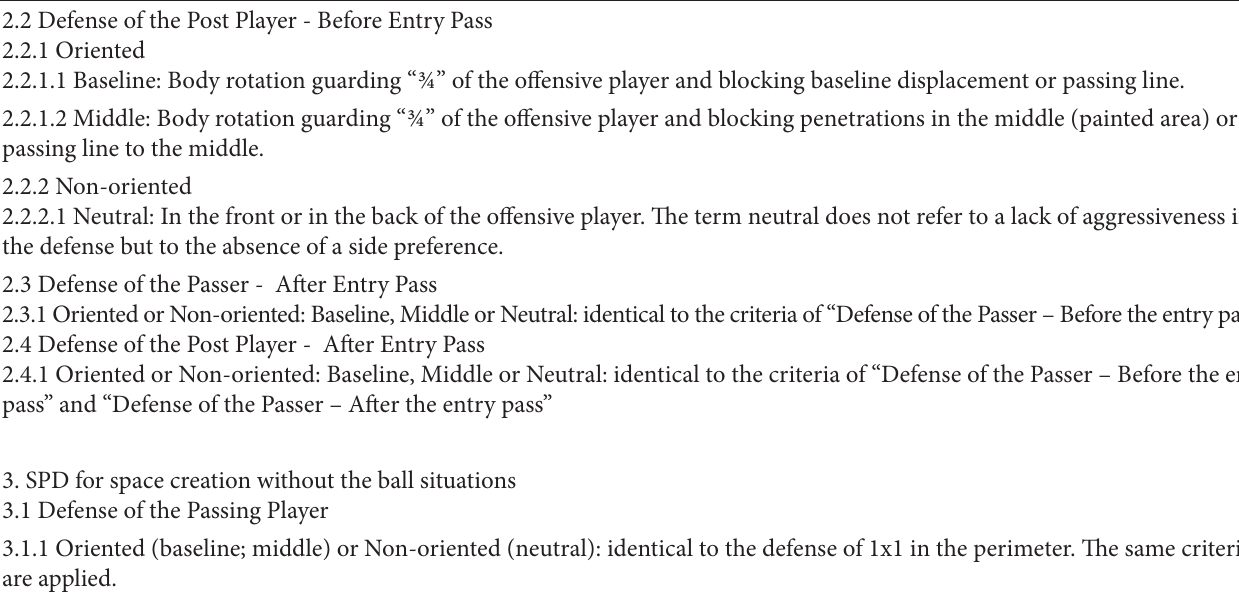
Table 1 (cont.). SPD classes for offense versus defense interactions involving 1x1, 2x2 and 3x3